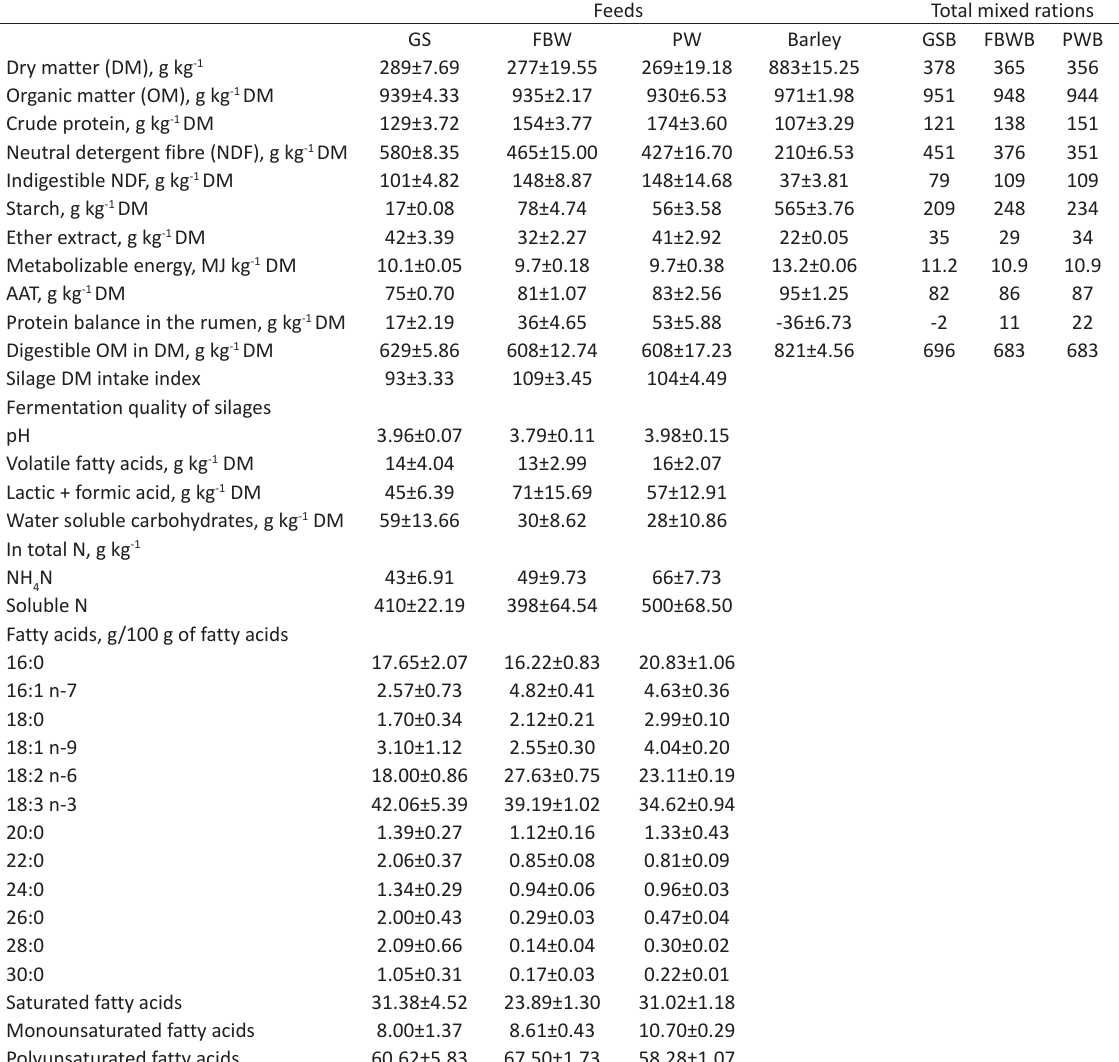
Table 1. Chemical composition and feeding values (mean ± standard deviation) of the ingredients and total mixed rations and fatty acid profile (12 most common fatty acids) of the experimental silages used in the feeding experiment. Number of samples: silages 7, barley grain 3 Feeds